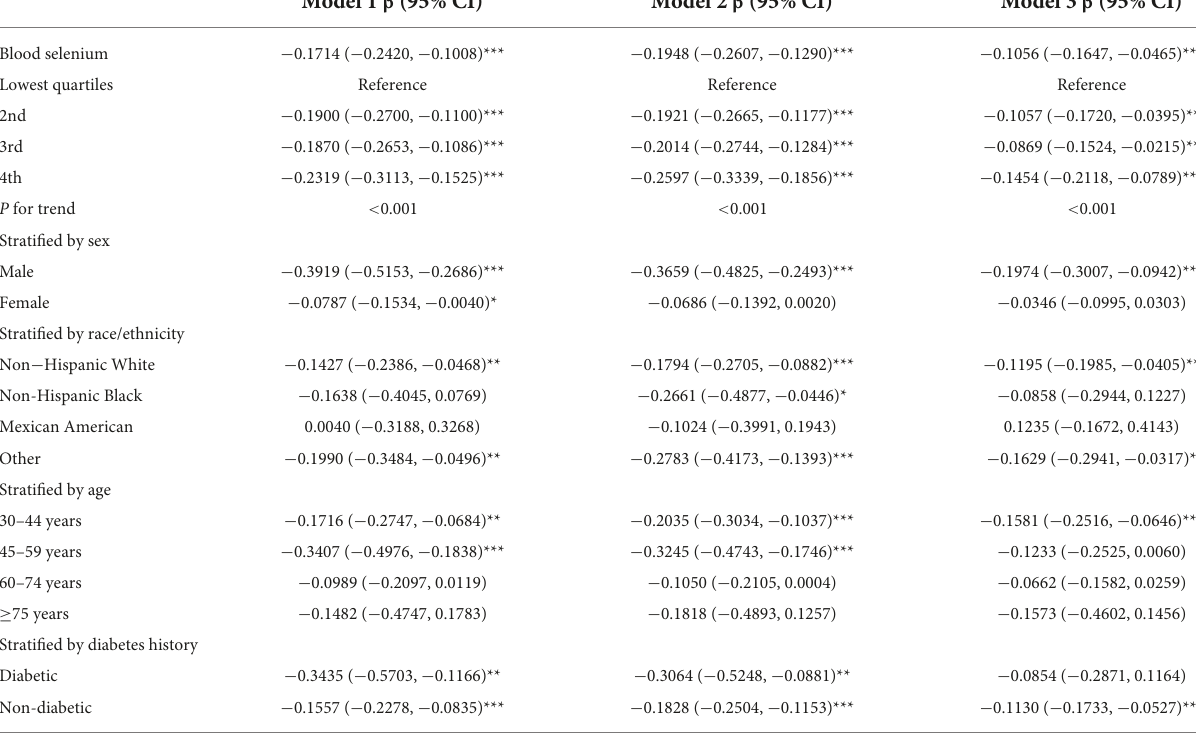
TABLE 6 Association between blood selenium concentration ( µ mol/L) and CAL (mm), and stratified by sex, race/ethnicity, age, and diabetes